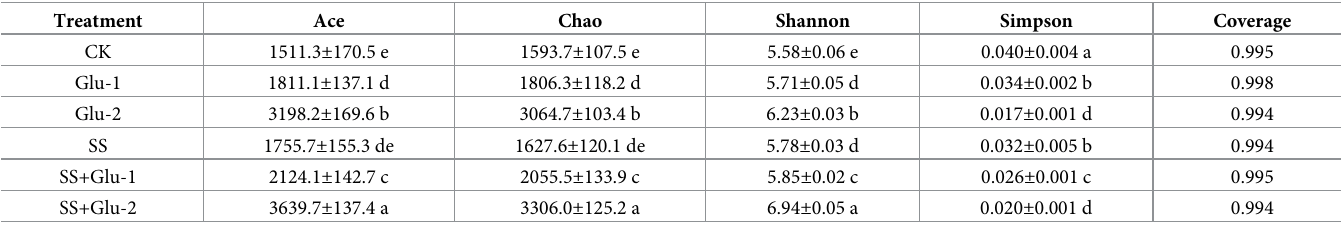
ments. The Ace, Chao, Shannon, and Simpson indices were used to evaluate the richness and were increased with the glucose addition levels, whereas the Simpson index showed the oppo- increased the values of Ace, Chao and Shannon indices by 13.8%, 7.9% and 11.4%, respectively; and sterilized soil with low level of glucose addition increased them by 17.3%, 13.8% and 2.6%, respectively. Table 1. The alpha diversity indices of bacterial communities in the sterilized and non-sterilized soils with glucose addition at day 45. Treatment Ace Chao Shannon Simpson